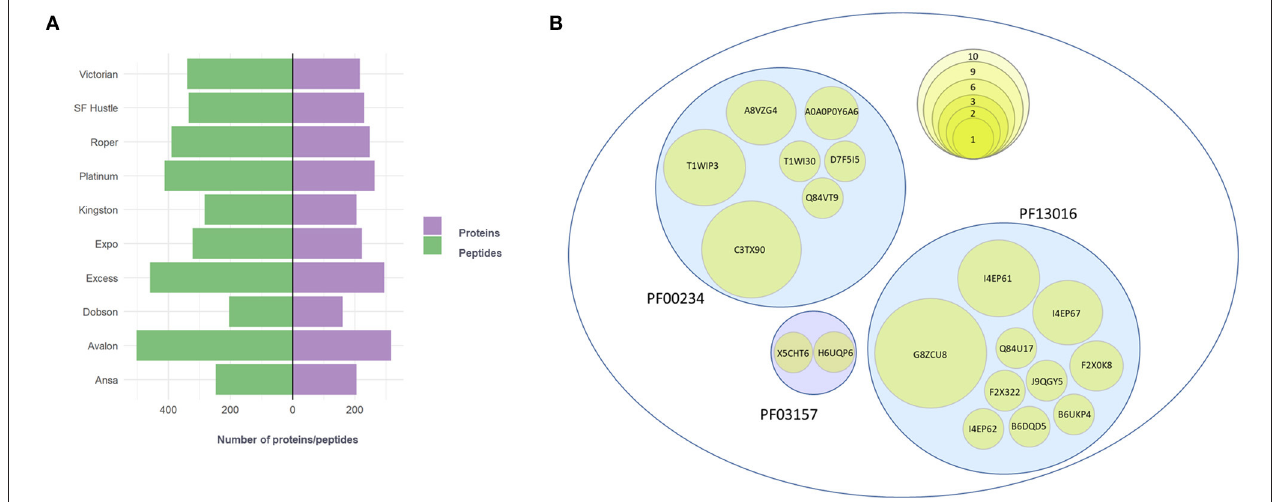
FIGURE 1 | (A) Number of proteins (purple) and peptides (green) detected at 1% FDR (99% confidence) for 10 ryegrass cultivars. (B) Proteins identified with the protein family search (Pfam) that belong to three specific families: PF00234-Tryp_alpha_amyl, PF13016-Gliadin, and PF03157-Glutenin_HMW. The size of the circle represents the number of identification occurrences among 10 cultivars of